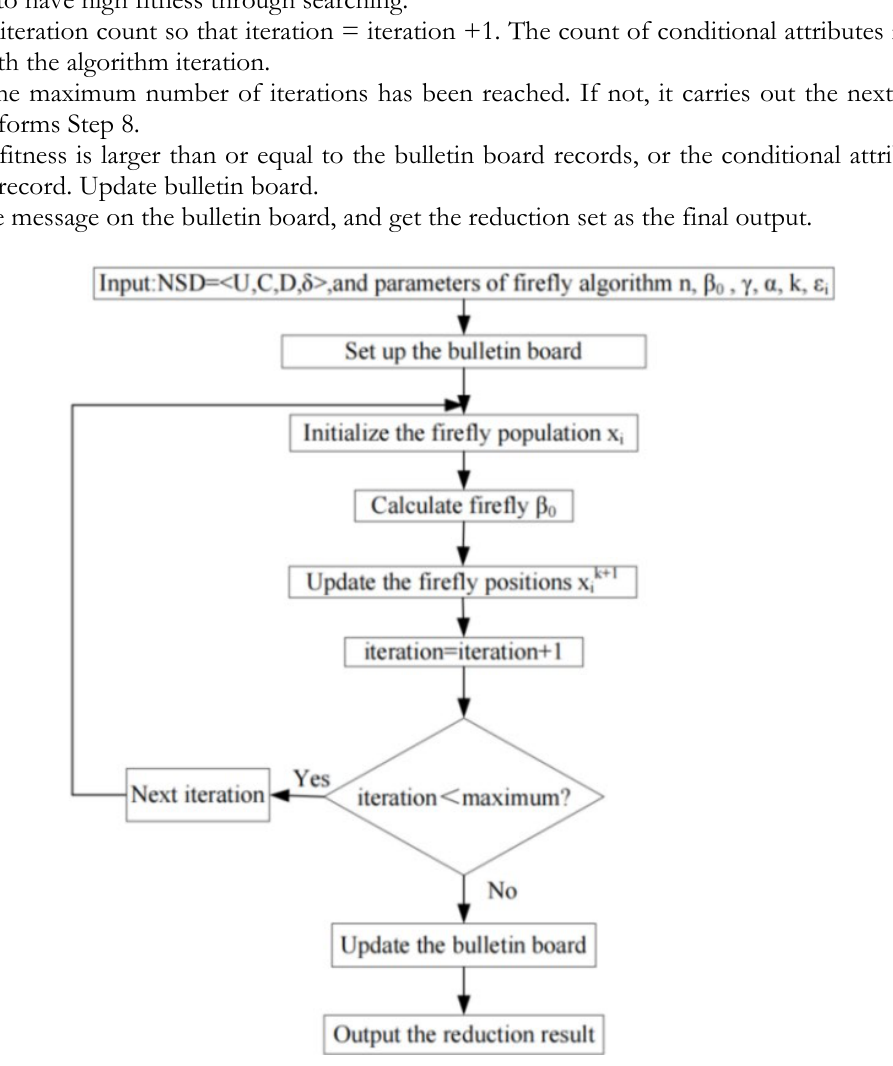
Figure 3: the flow chart of IFANRSR